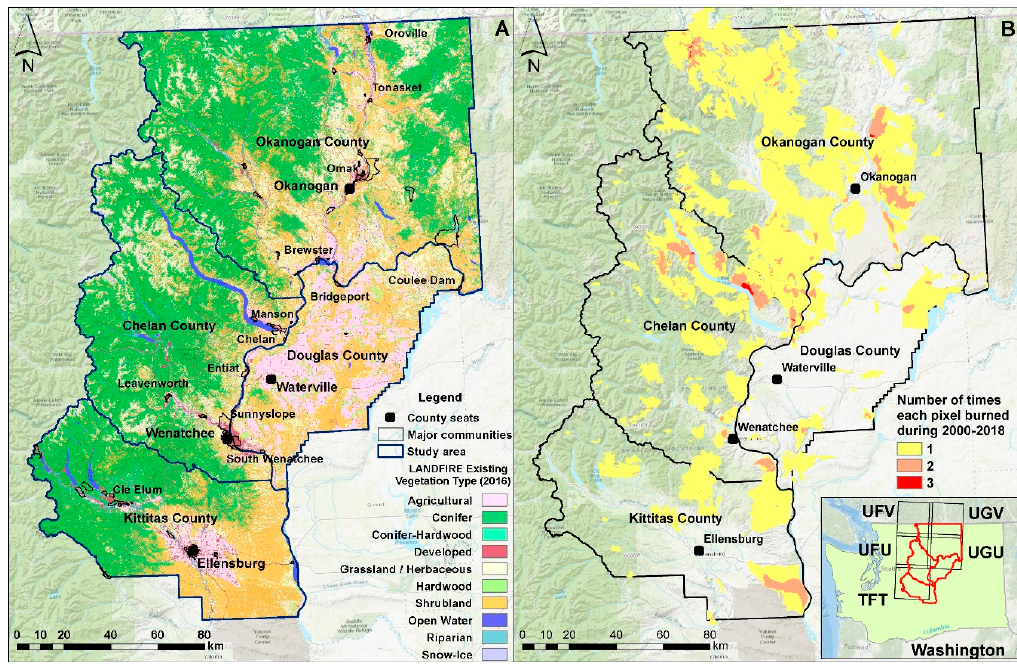
Figure 1. ( A ) Existing vegetation types of 2016 (data source: LANDFIRE); ( B ) Number of times each area was burned during the period of 2000–2018 (data source: LANDFIRE disturbances [16] and Monitoring Trends in Burn Severity [42] ); Inset map shows the location of the four counties over the state of Washington, while black rectangles depict the boundary of each of the five Sentinel-2 tiles.